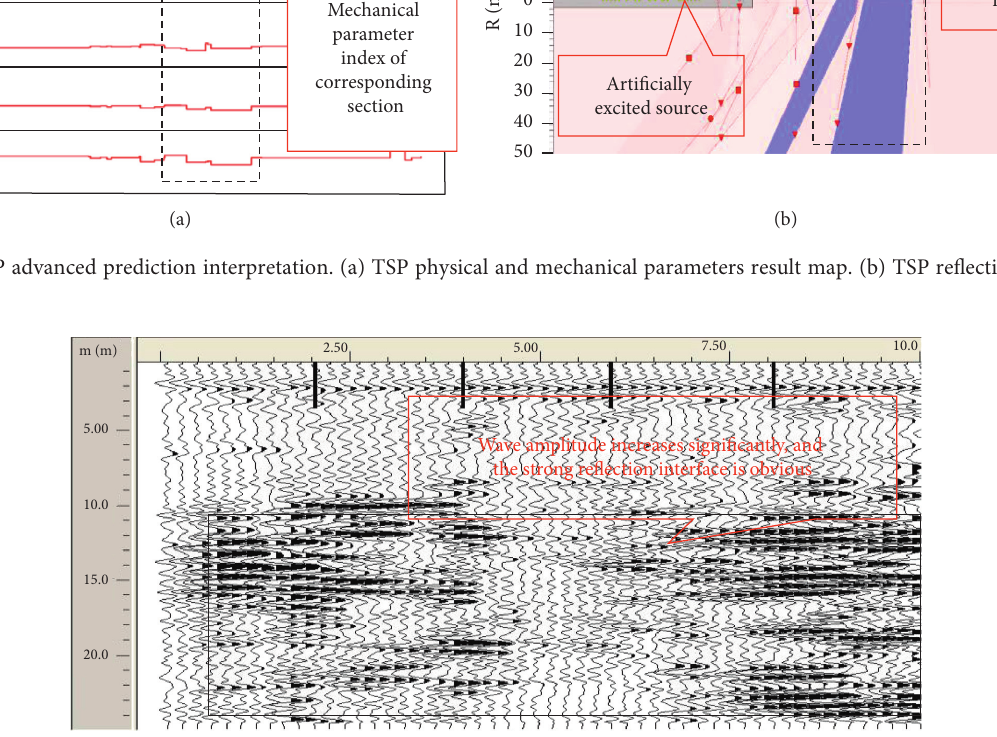
Figure 10: Ground penetrating radar interpretation map of the K42 +510–K42 +540 section.